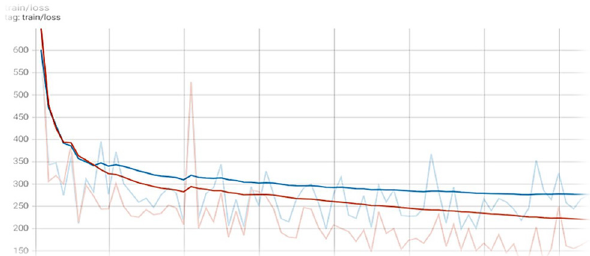
Figure 5 Model convergence speed